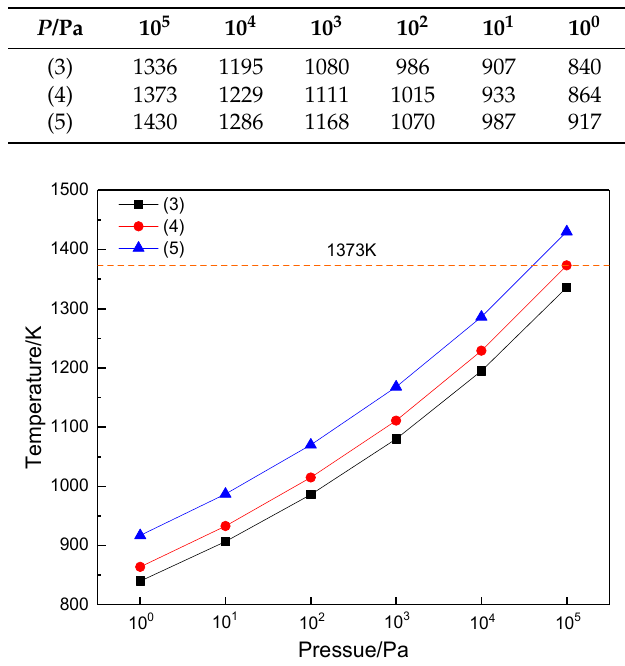
Table 6. The theoretical minimum temperature (K) for each reaction under different pressure. P /Pa